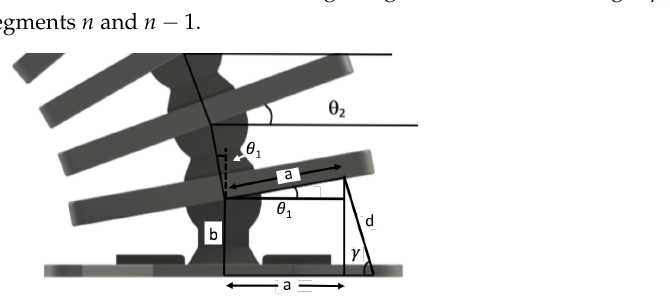
Figure 8. Local geometric parameters used to develop the